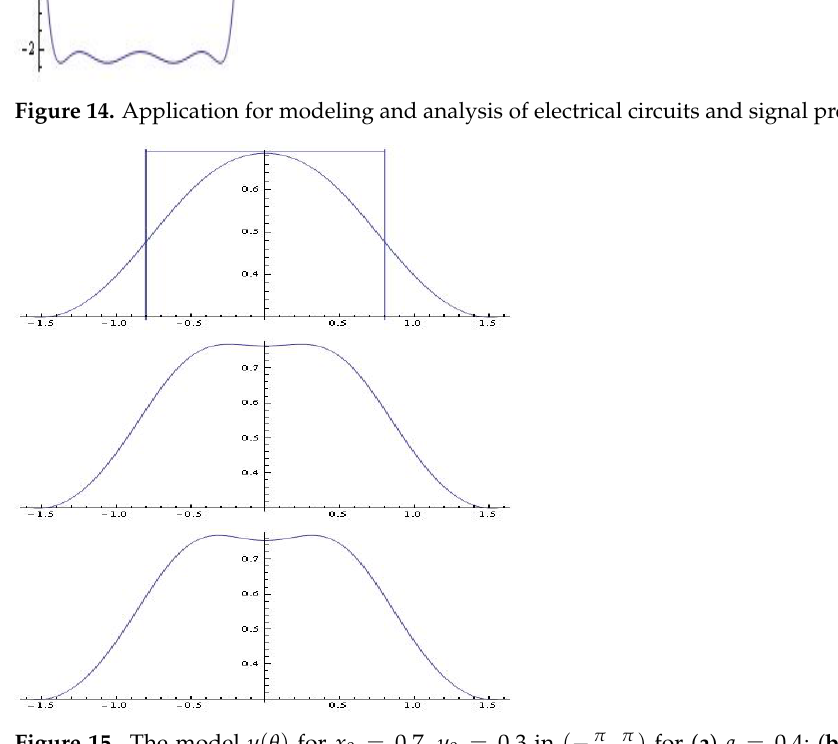
Figure 15. The model y ( θ ) for x 0 = 0.7, y 0 = 0.3 in ( − π ( c ) a =